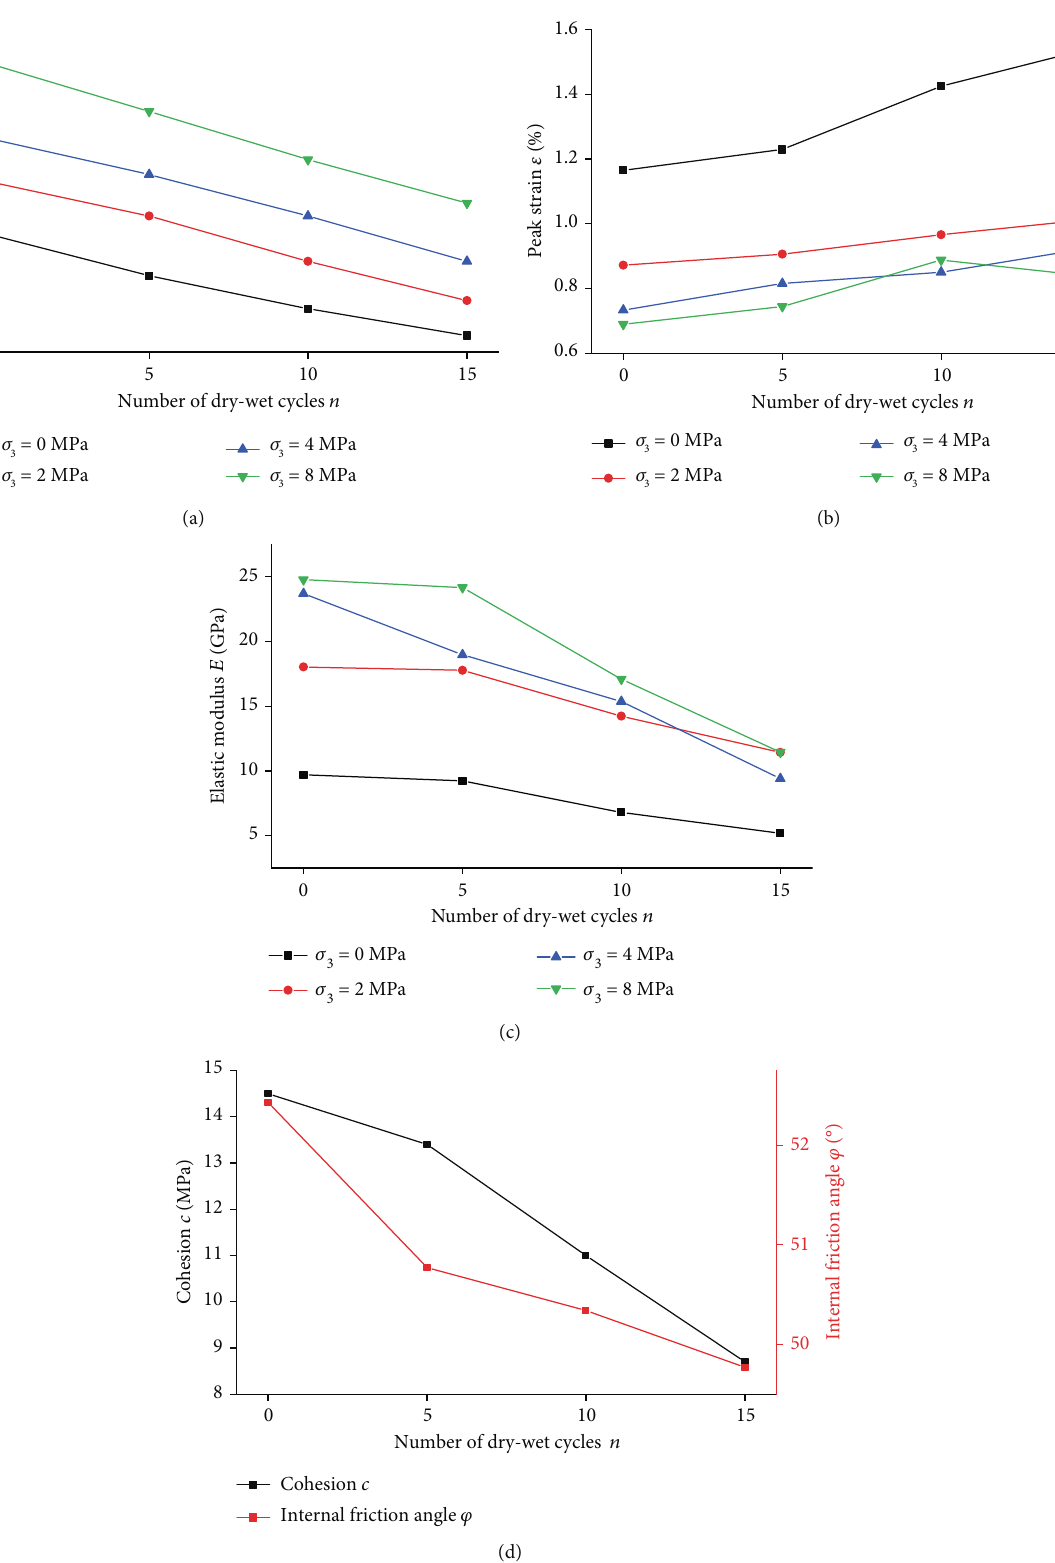
Figure 8: Deterioration of sample mechanical